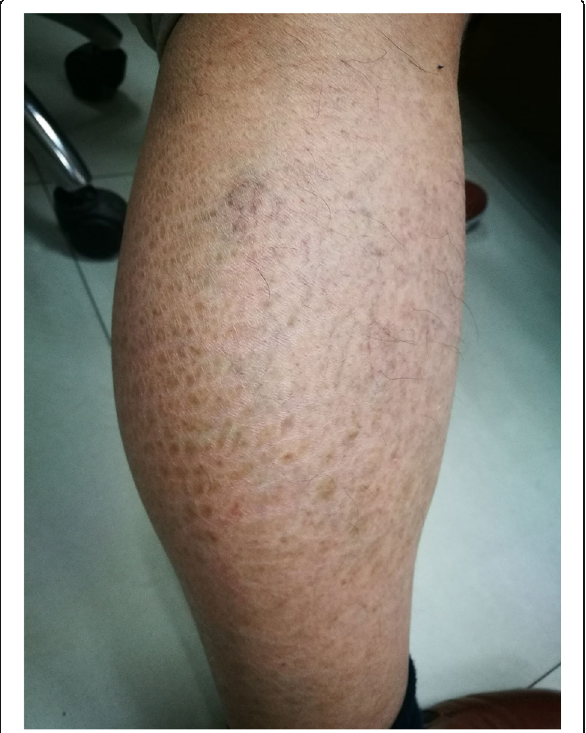
Fig. 1 Clinical appearance of the proband co-inherited with XLI and IV. The proband had obvious, widespread and hyperpigmented ichthyosis in extensor surfaces of lower limbs even after